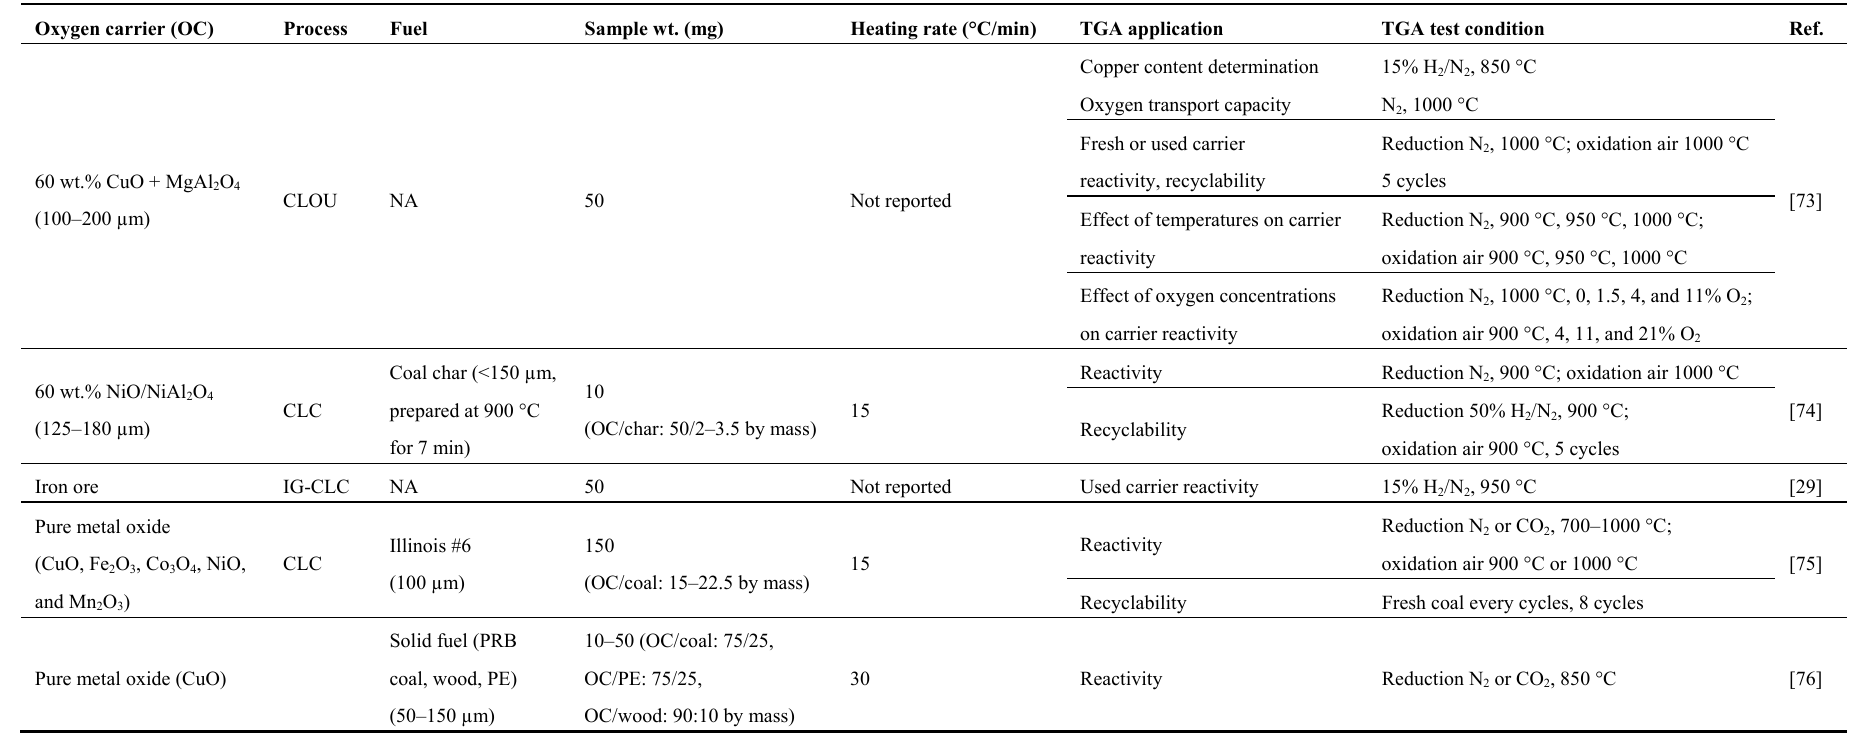
Table 1. Experimental lab scale studies on oxygen carrier development for coal chemical looping process using